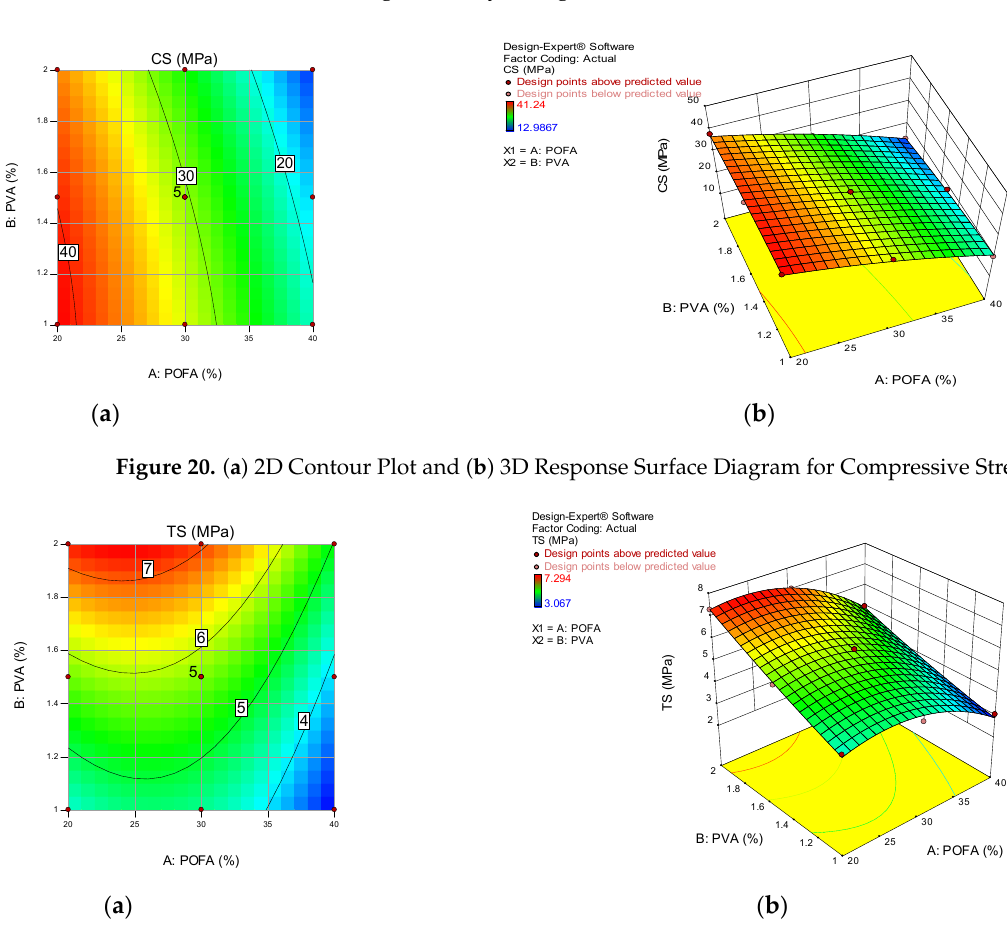
( b ) Figure 19. ( a ) Normal Plot for the Residual and ( b ) Predicted Versus Actual Plot for the TSC model. Other vital tools used to assess the interaction between the variables are the model graphs, which include the 2D contour and the 3D response-surface diagrams. As shown in Figures 20–23, these plots are color-coded to show the influence of the interaction of the input factors on the responses. Red regions represent areas with high response intensity, while blue regions represent low response magnitudes. The intermediate response values are represented by the yellow and green regions. For example, Figure 20a,b depict the 2D